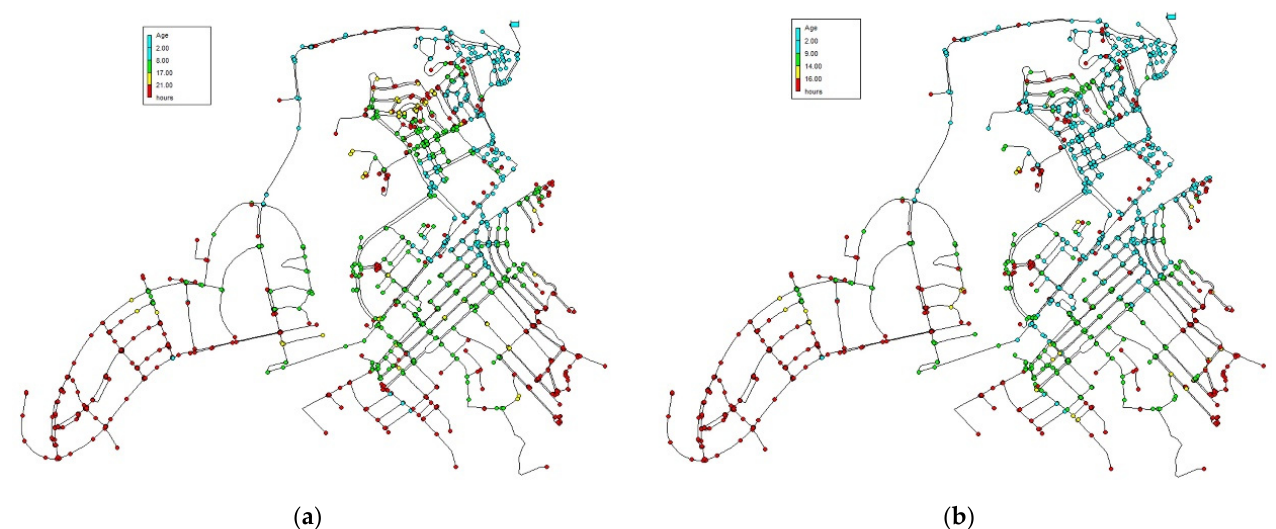
Figure 9. Water age distribution over the network in Case Study 1 ( a ) in winter and ( b ) in summer.